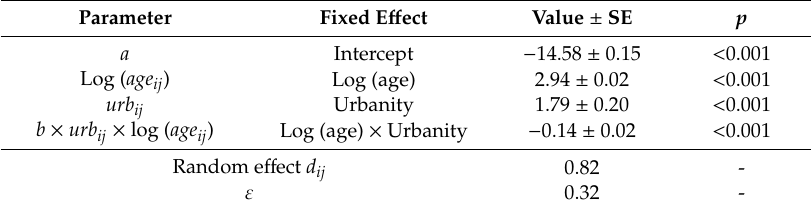
Table 7. Results of the linear mixed model on the annual basal area increment (mm 2 yr − 1 ) of all analyzed trees (response variable) with the individual tree code as random e ff ect. The fixed e ff ects are log (age), the grade of urbanity (urban and rural) and their interaction.